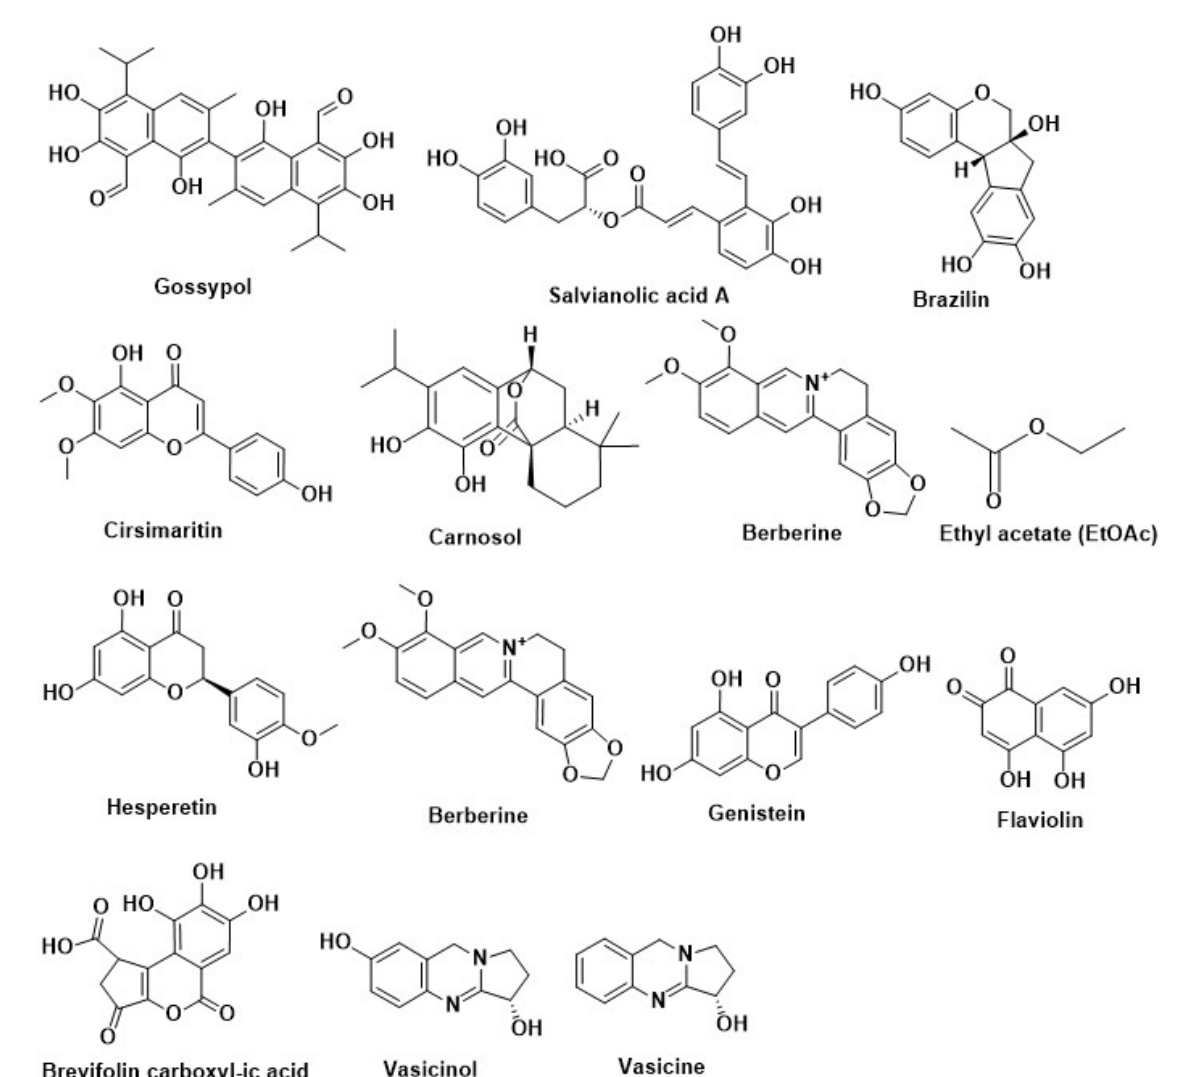
Figure 5. Chemical structures of phytocompounds against diabetes.